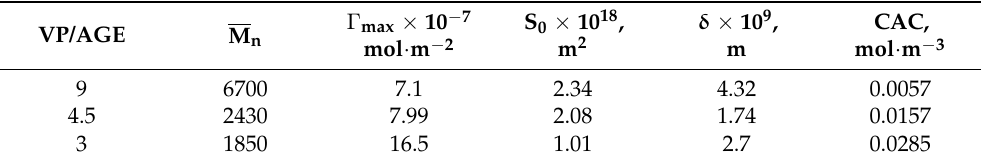
Table 1. Properties of surfactants based on amphiphilic copolymers of N -vinyl-2-pyrrolidone and allyl glycidyl ether containing a terminal n -octadecyl group. VP/AGE